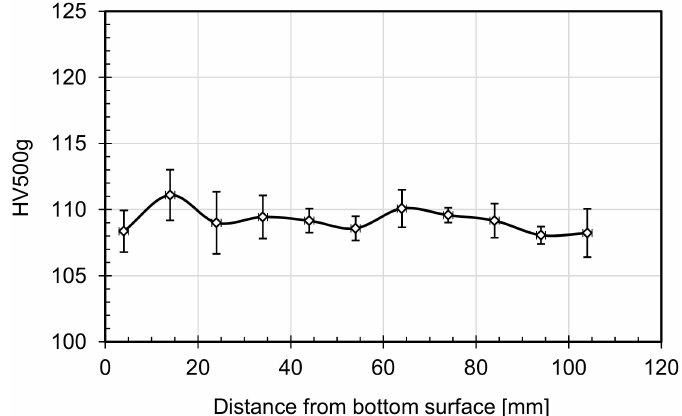
Figure 9. Microhardness profile measured in a HP AB sample as a function of position along build direction. Data refers to average and standard deviation values out of five microhardness readings per